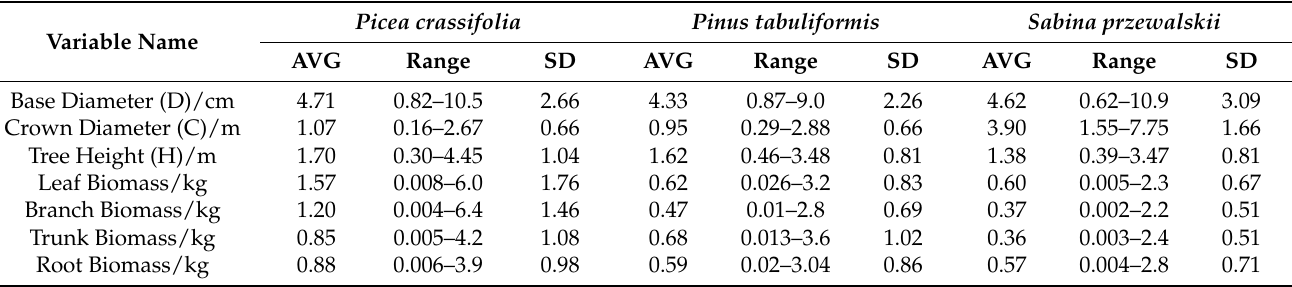
Table 1. Statistical characteristics of the sample